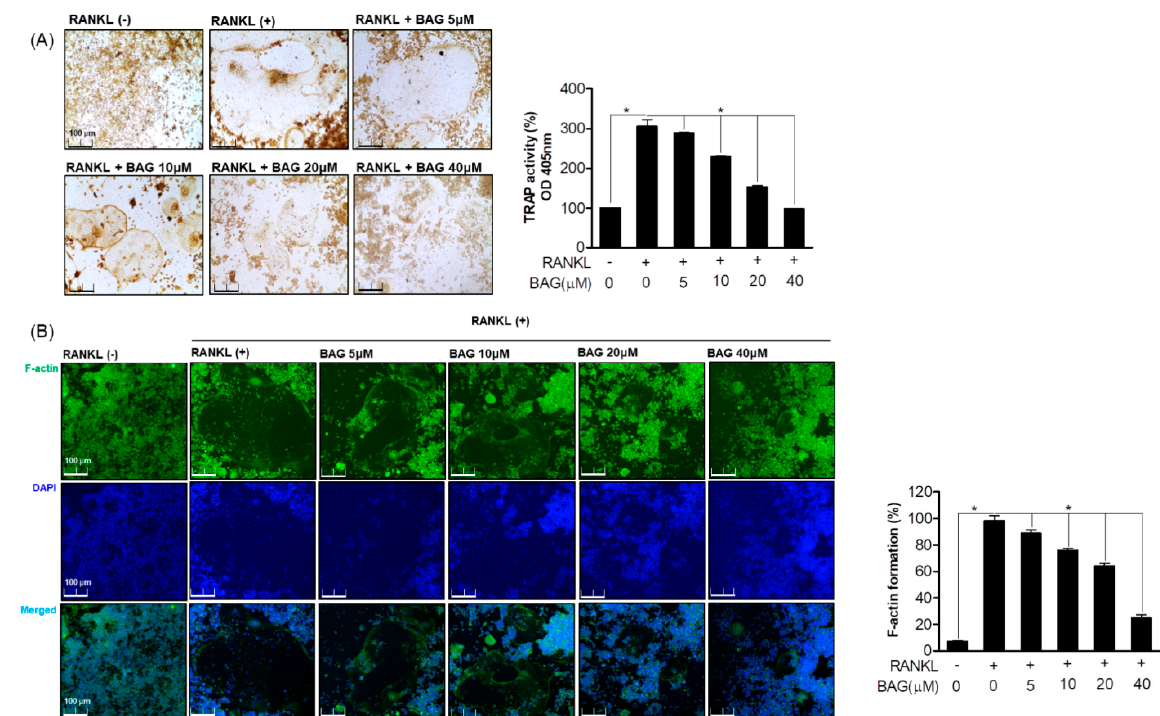
Figure 2. Inhibitory Effect of BAG on RANKL induced osteoclast differentiation. ( A ) RAW264.7 cells were seeded in a 24 well plate at a density of 5 x 10 3 and treated with RANKL with various concentrations of BAG (5–40 μ M) for 5 days, and then TRAP staining and activity were measured. ( B ) As a representative fluorescence micrograph of the effect of BAG on F-actin belt formation, the indicated concentrations of BAG (5–40 μ M) were treated with RANKL for 5 days. The actin cytoskeleton was then stained with Alexa 488-Phalloidin (green), and the nuclei were counterstained with DAPI (blue). * p < 0.05, versus the RANKL treated group.